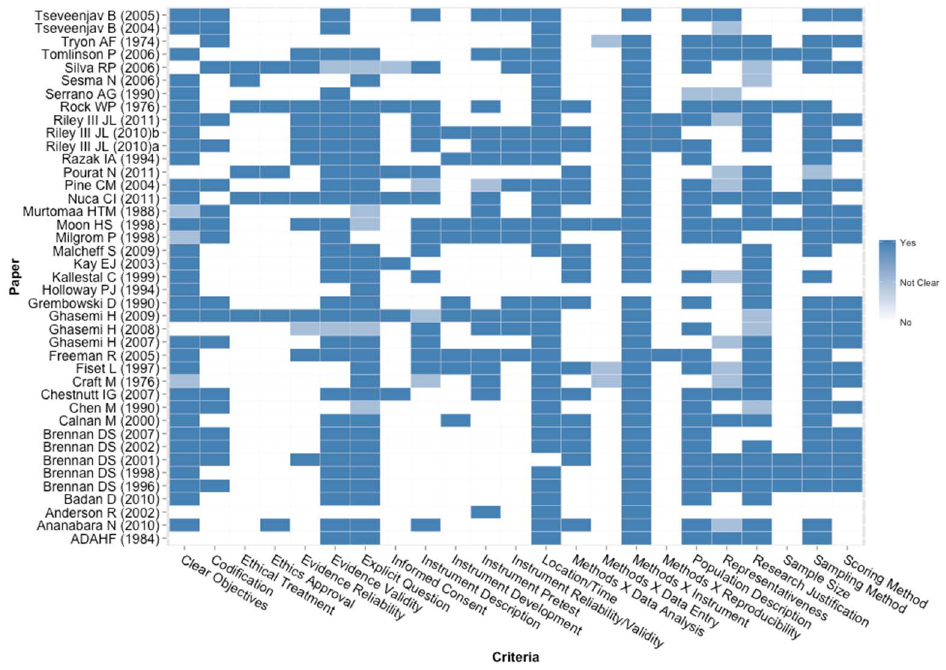
Figure 2. Heat map showing a gradient of quality indicators for each individual survey included in the analysis. Colors vary from white (No), light blue (Not Clear) and blue (Yes) representing the three categories used in the quality assessment.